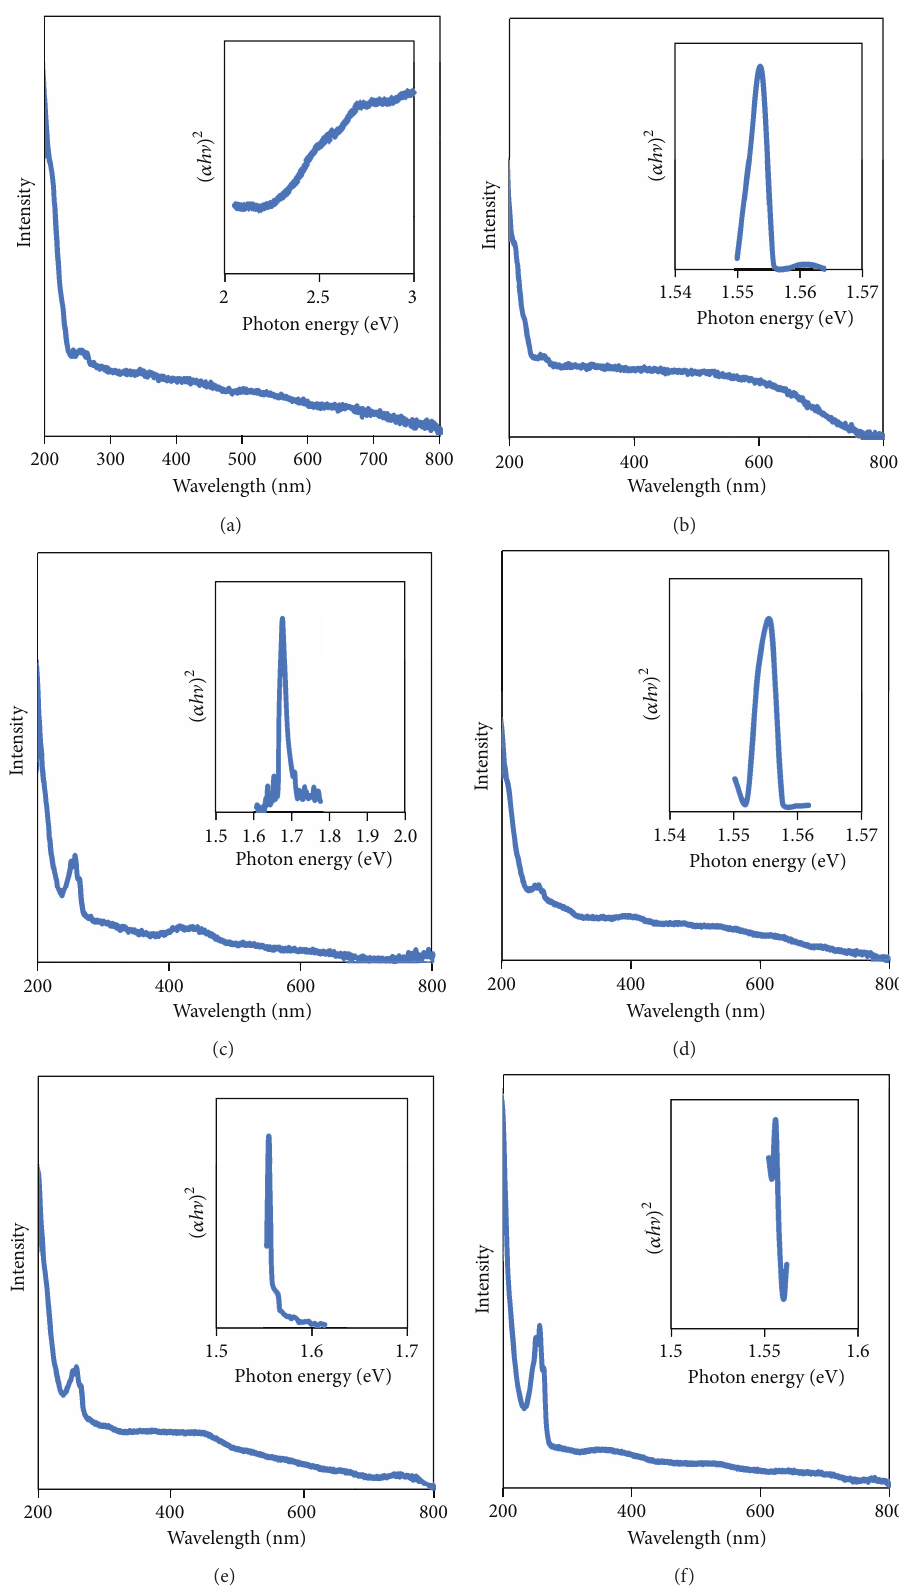
Figure 11: Optical absorbance spectra of HCl functionalized 𝛼 CNTH/Ag nanohybrids at different molars of AgNO 3 : (a) 0 M, (b) 0.01 M, (c) 0.05 M, (d) 0.1M, (e) 0.5 M, and (f) 1M. Inset shows Tauc plot for each